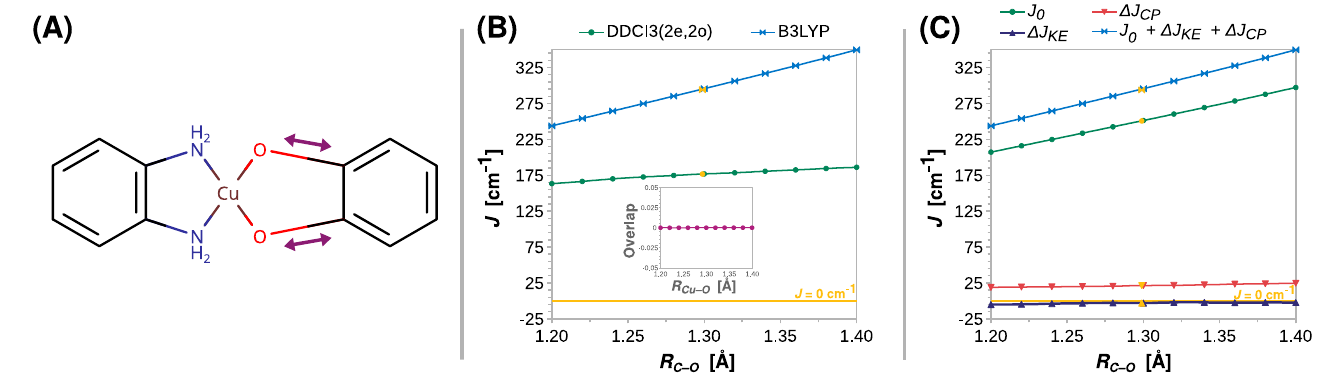
Figure 5. Rigid scan of J along the C–O distance ( R C–O ): schematic representation of the varied struc- tural parameter ( A ); the parameter J predicted at the B3LYP and DDCI3(2e,2o) levels and DDCI3(2e,2o) ( B ); decomposition of J at the B3LYP level ( C ). Inset in ( B ) shows the overlap of the magnetic orbitals calculated at the B3LYP level. All are calculated with the def2-TZVP basis set. For clarity, the line J = 0 cm − 1 is shown as a reference. For the geometry optimized at the B3LYP/def2- TZVP theory level, R C–O = 1.294 Å (labeled with the yellow symbols).